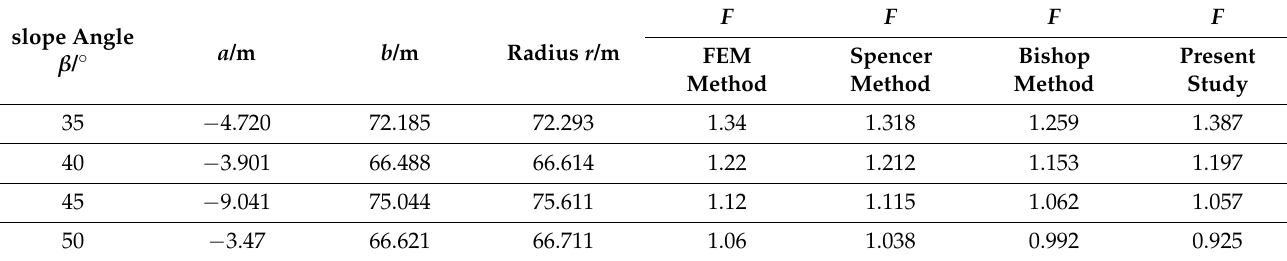
Table 2. Results of safety factor (case